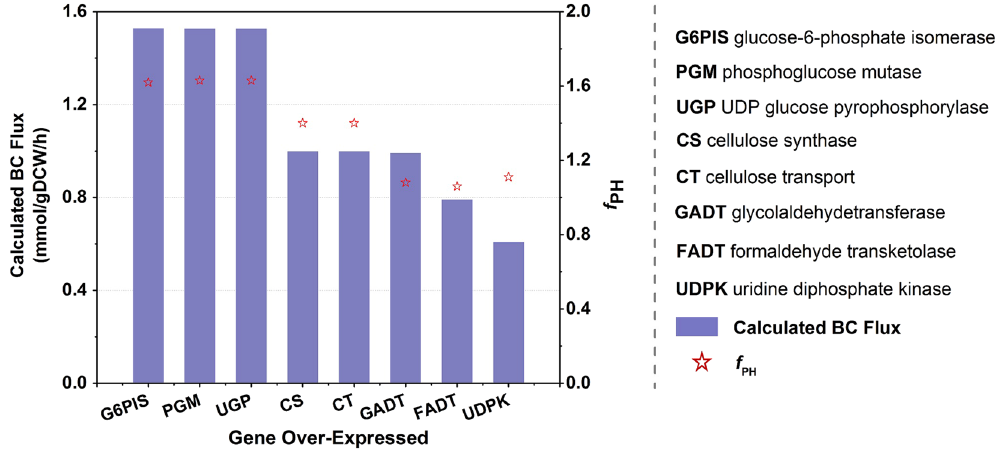
Figure 5. Calculated BC production flux and f PH as a function of over-expression of a